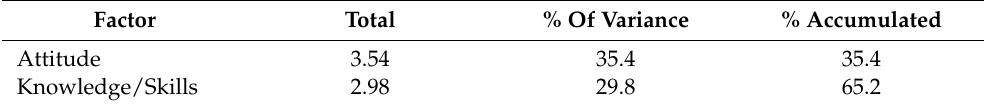
Table 7. Total explained variance.